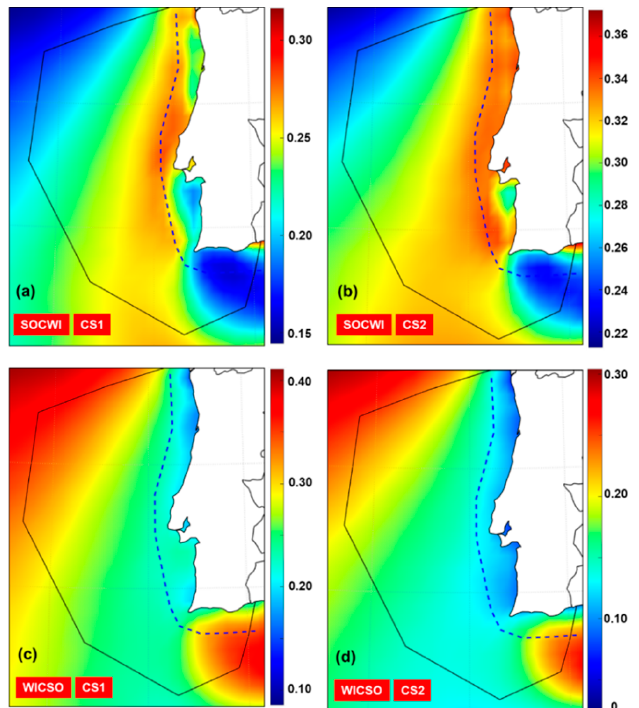
Figure 6. Spatial maps illustrating: ( a , b ) solar-wind power complementarity (SOCWI)—case studies 1 and 2, respectively; ( c , d ) wind-solar complementarity (WICSO)—case studies 1 and 2, respectively (where the dotted line indicates the 50km izoline).